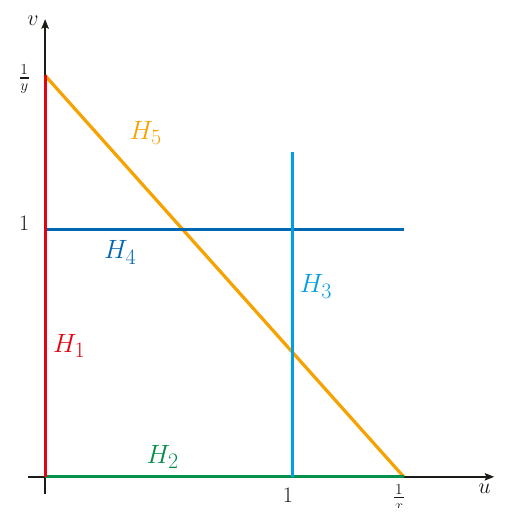
Figure 3 . Geometry for the Appell F 2 integral representation of eq.